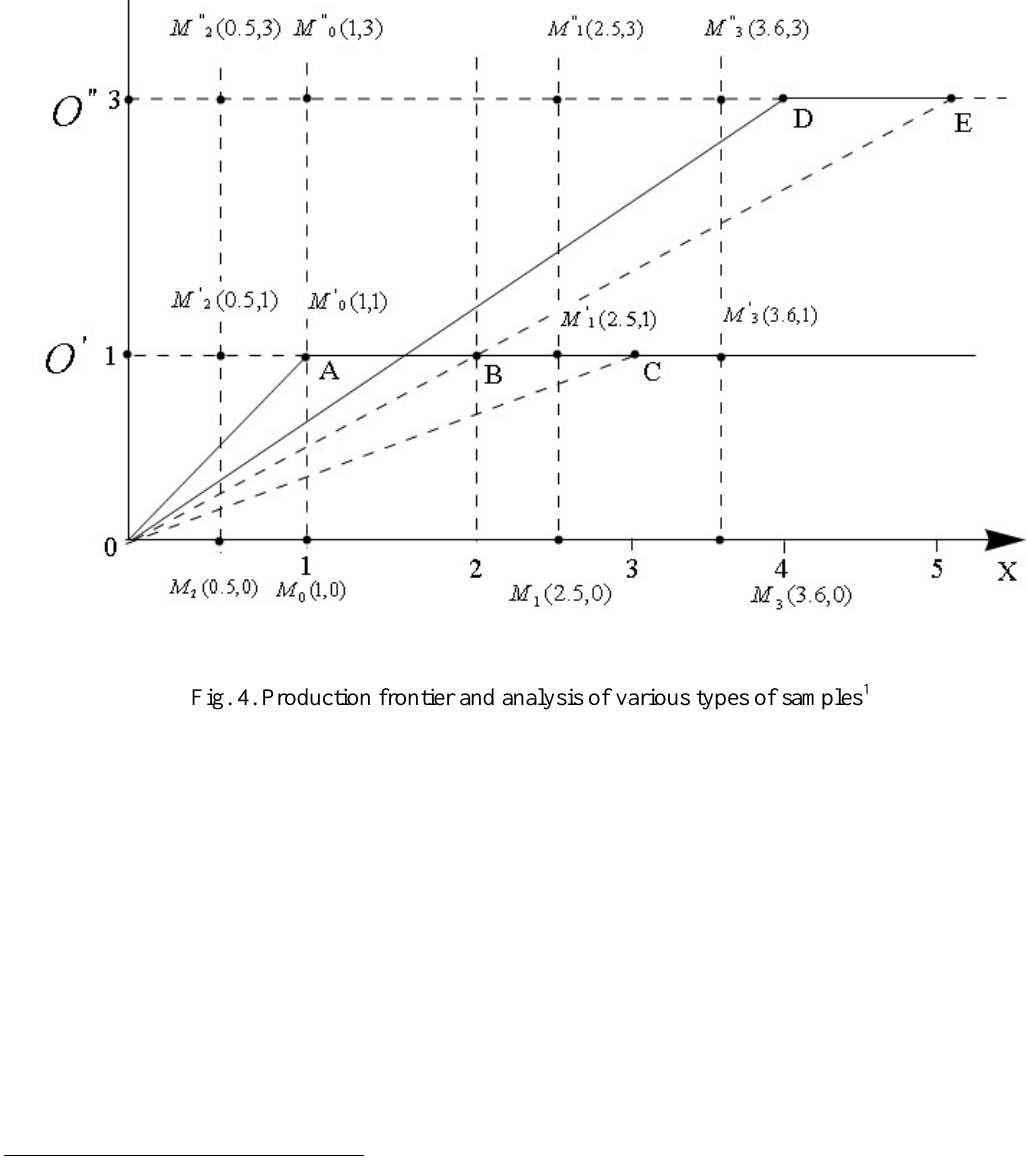
1 Dotted lines represent the worst-practice frontier; solid lines represent the best-practice